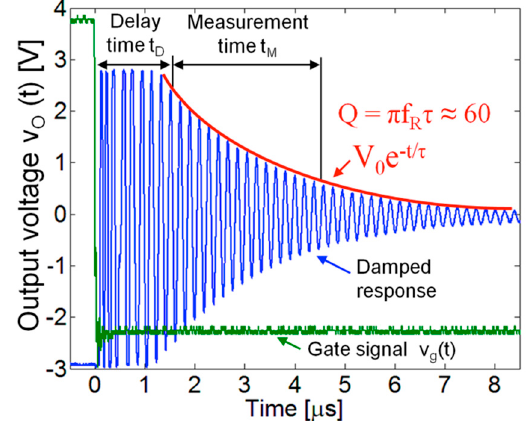
Figure 2. Measured output voltage v O ( t ) versus time during the detection phase obtained with interrogation distance d = 20 mm. The quality factor Q can be estimated from the exponential decaying envelope.